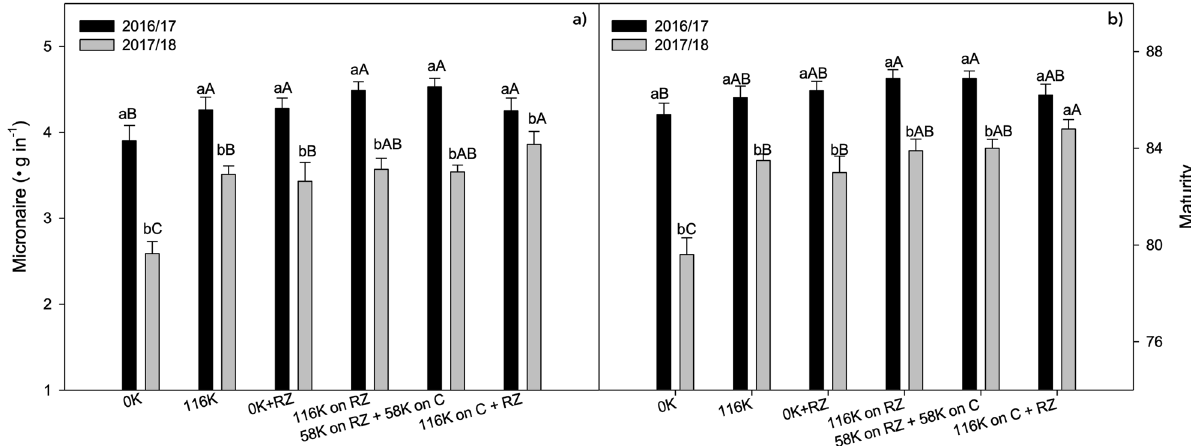
Figure 5. Micronaire ( a ) and fiber maturity ( b ) under potassium fertilization management. A > B for K management within each growing season and a > b for growing season within K management.